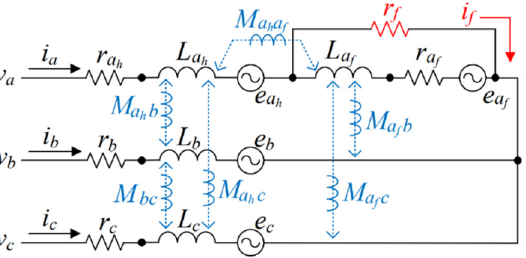
Figure 2. Three-phase electrical model for a PMSM with ITSC. Each phase is modeled using its resistance ( r s ), self and mutual inductance ( L and M ) and the back-EMFs ( e abc ). The ITSC is introduced by shorting a portion of healthy windings with a resistor ( r f ), which represents the insulation degradation between two shorted turns. Phase A is split into two separate windings, denoted as a h for the healthy part and a f for the shorted area. A circulating current, i f , is generated in the short-circuit path. The